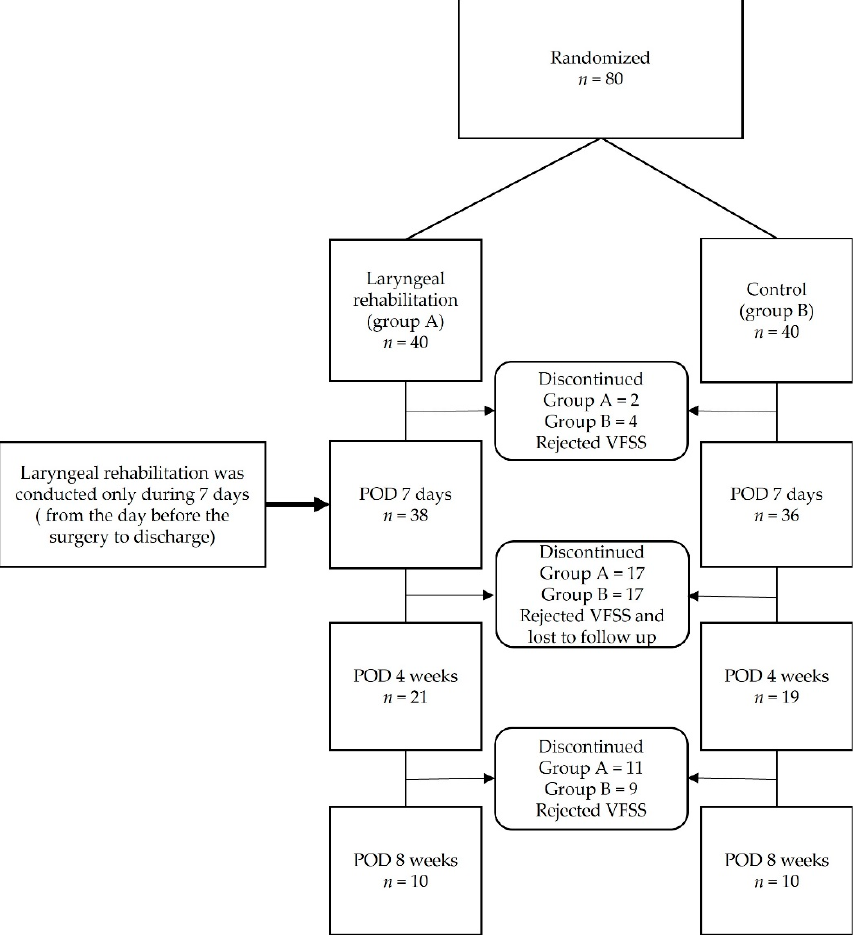
Figure 1. Study flow chart.